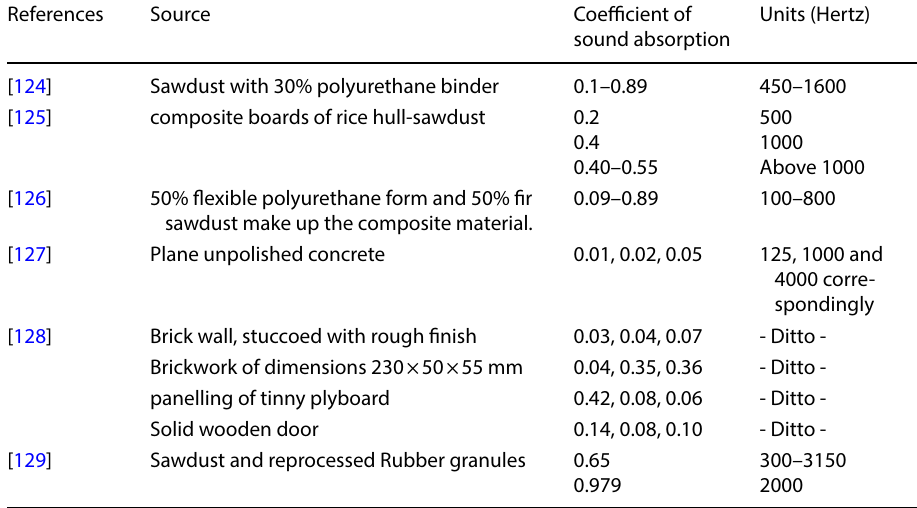
Table 6 Common structural materials’ sound